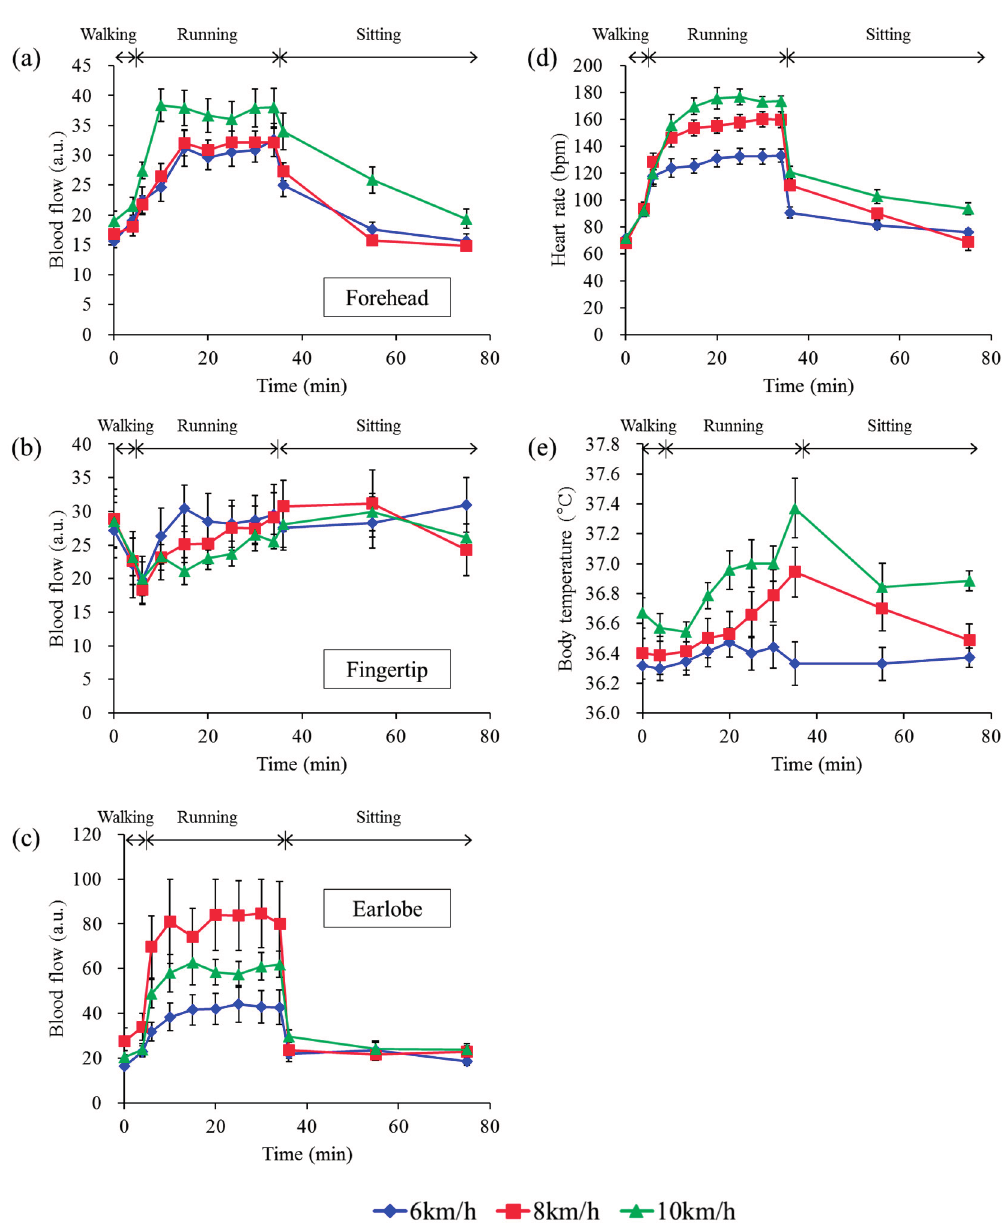
Figure 6. Changes in blood flow and other parameters at each running speed. Mean blood flow at the forehead ( a ); the fingertip ( b ); and the earlobe ( c ); heart rate ( d ); and body temperature ( e ). Error bars represent standard error. Seven subjects ran at 6 km/h (blue rhomboids), 8 km/h (red squares), and 10 km/h (green triangles) for 30 min. Two of